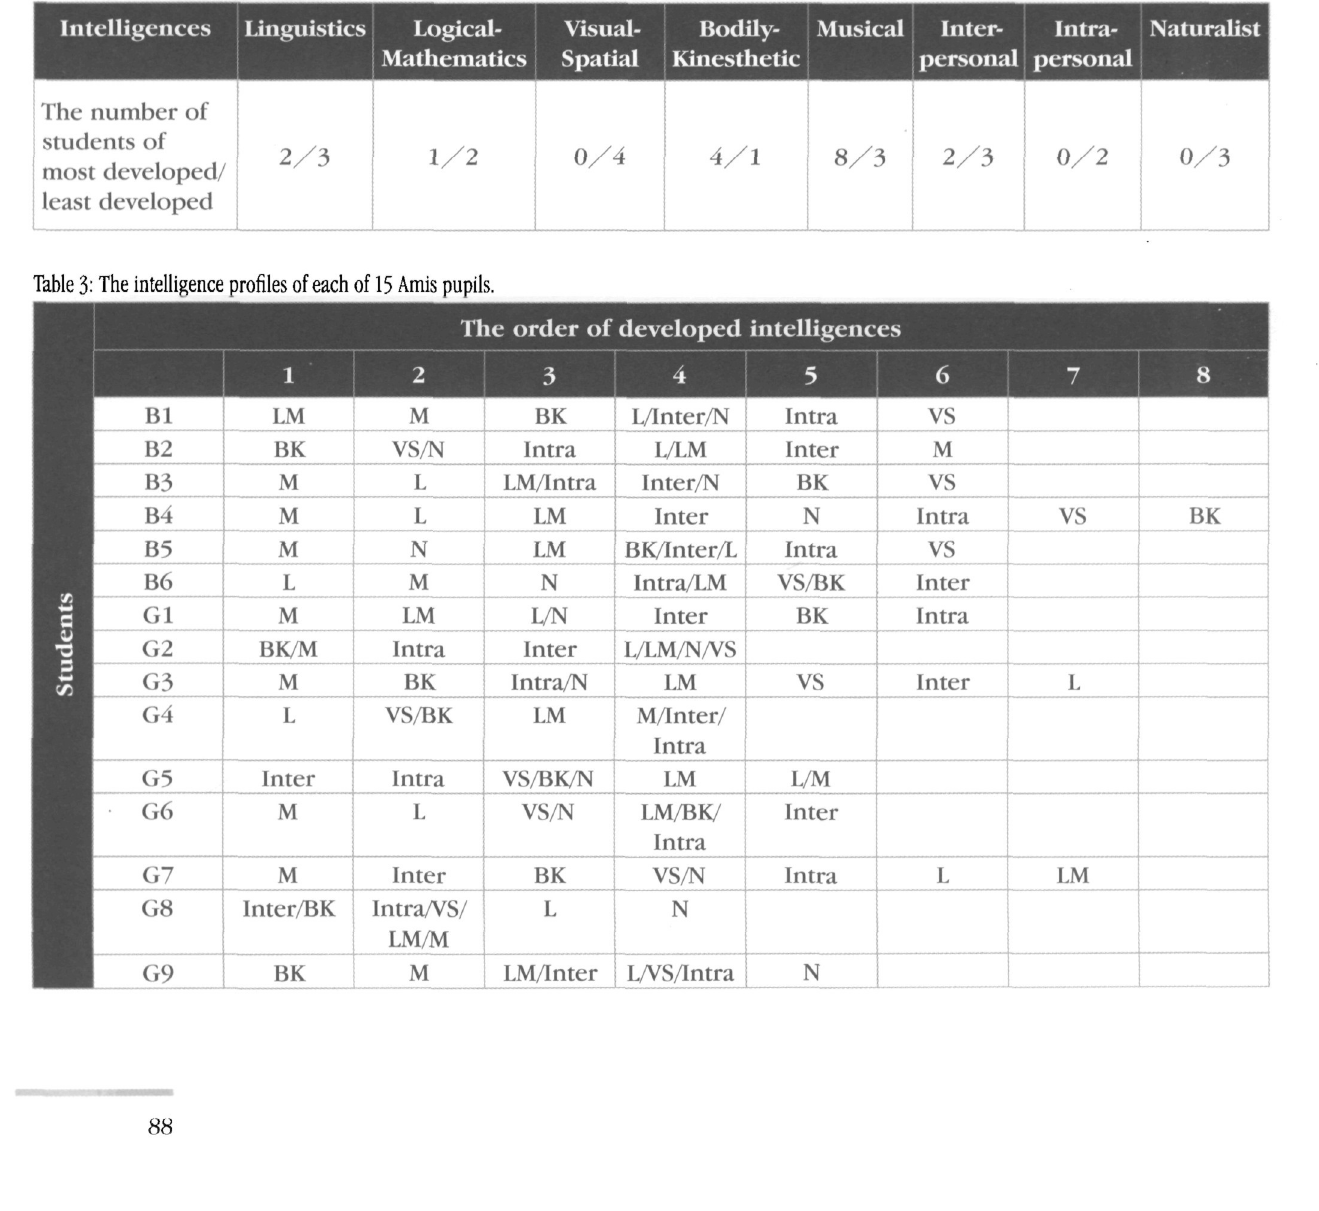
Table 2: Each intelligence with the number of most and least developed Table 3: The intelligence profiles of each of 15 Amis